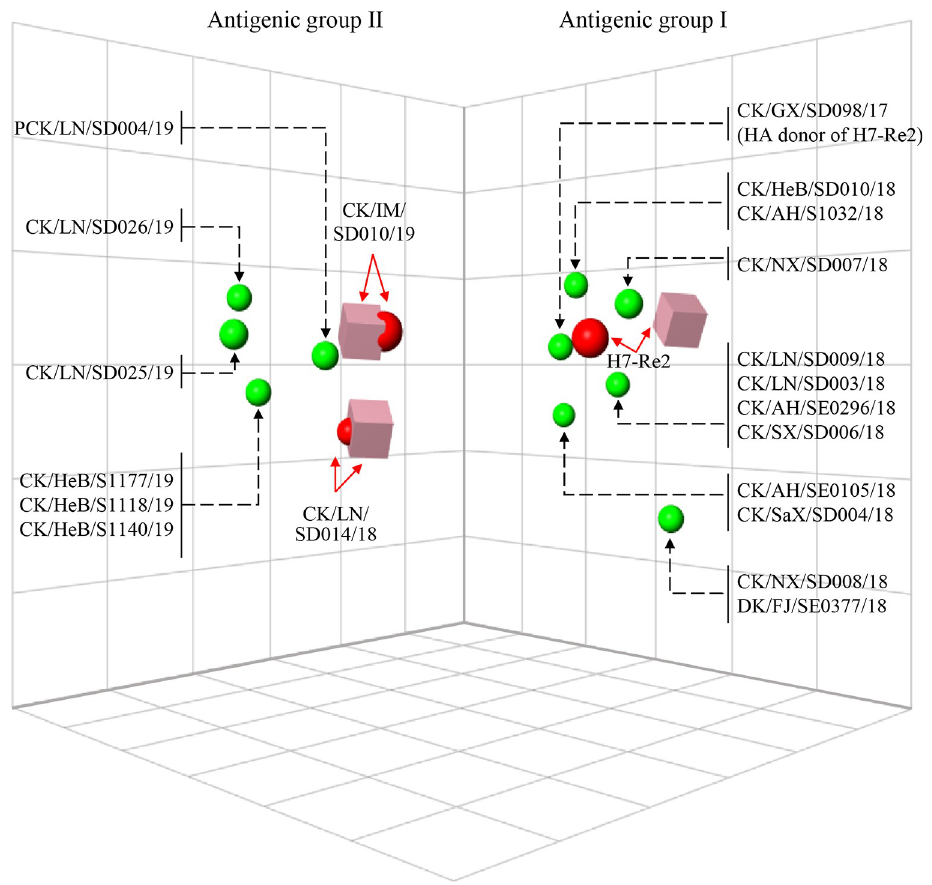
Fig 4. Antigenic cartography of H7N9 viruses. The antigenic map was generated by using the HI assay data shown in S2 Table. Each unit in the coordinate represents a 2-fold difference in HI titer. The pink cubes represent the antisera generated from the indicated viruses. The red balls indicate the viruses used for antisera generation, and the green balls show the test viruses.